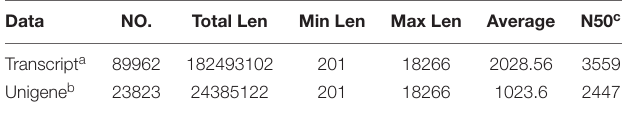
TABLE 3 | Functional annotation statistics of the Floccularia luteovirens assembly